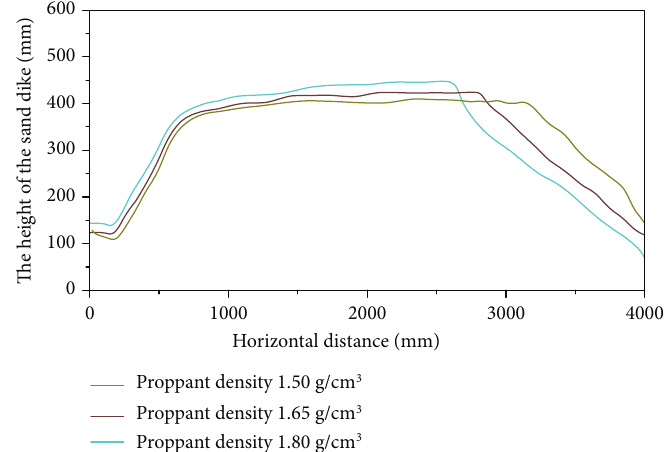
Figure 10: The shape of the sand dike formed by proppant sedimentation in sand carrying by slickwater with di ff erent proppant